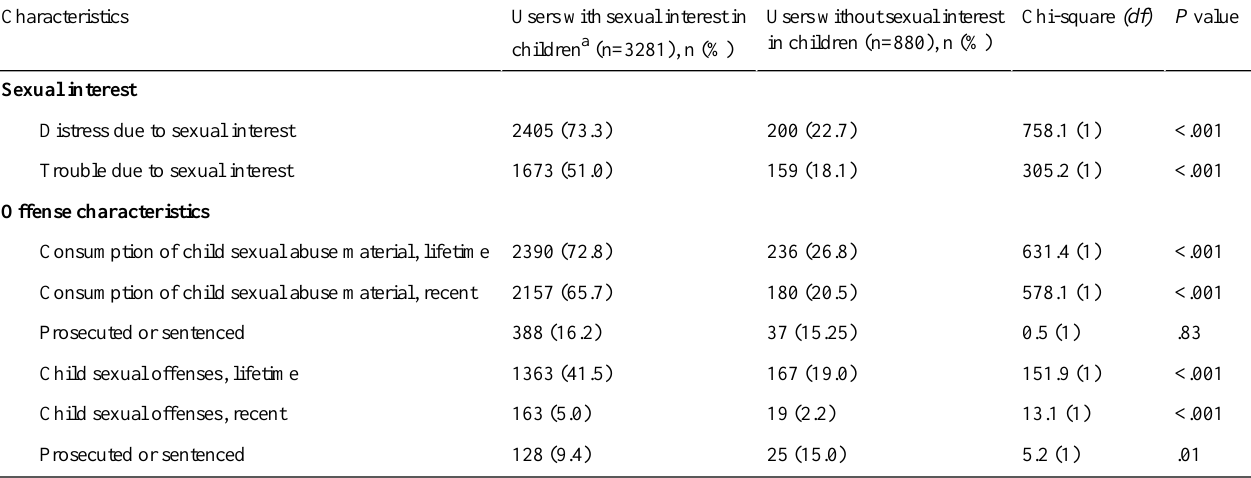
Table 1. Sexual interest and offense characteristics of the users of the Troubled Desire app (N=4161).